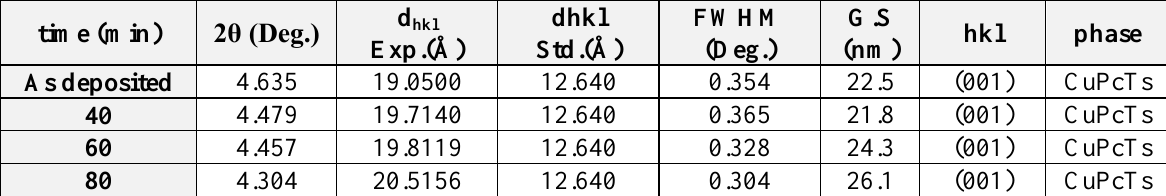
Table 2: Structural parameters of CuPcTs/PEDOT:PSS thin films chemically treated with Talwen at different immersing